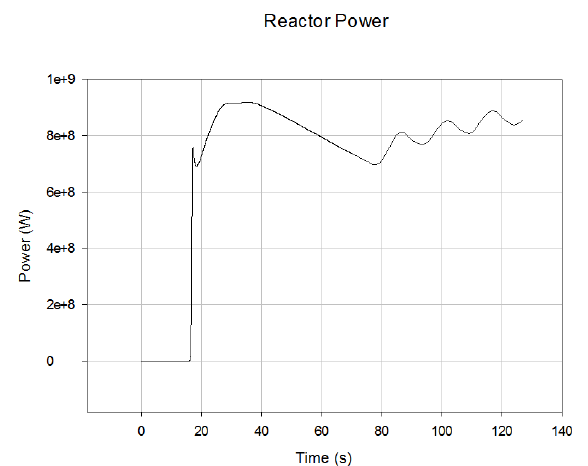
Figure 12. Core power.